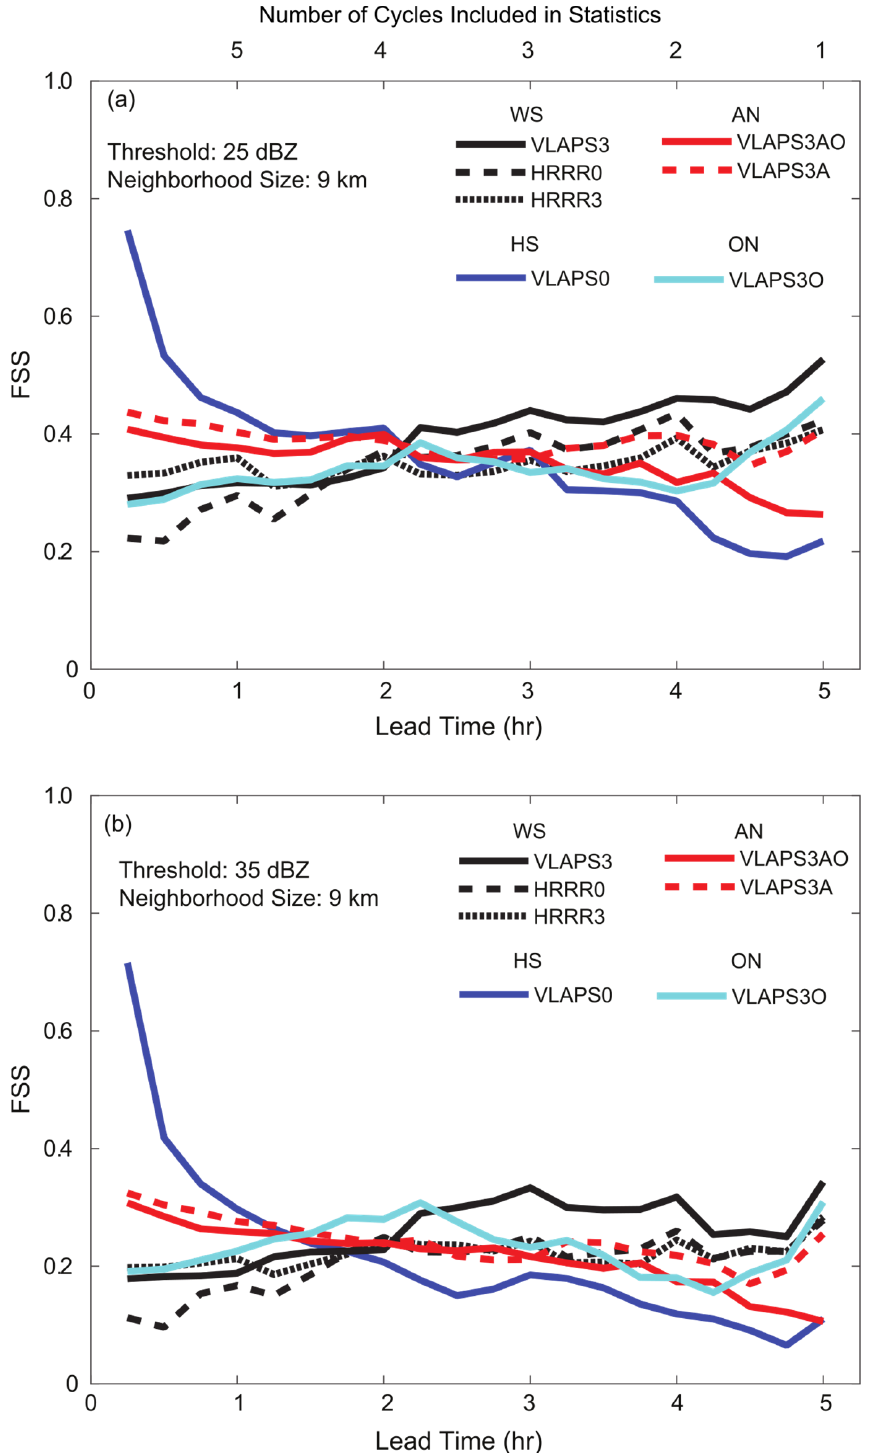
Figure 7. FSS by lead forecast time (by experiment) and for ( a ) 25 dBZ and ( b ) 35 dBZ reflectivity threshold levels (for a 9 km neighborhood size). Line colors indicate whether an experiment is in the warm start (WS), hot start (HS), analysis nudge (AN), or observation nudge (ON) group. The number of cycles included in the statistics at each integer lead time hour is shown along the top of the figure.